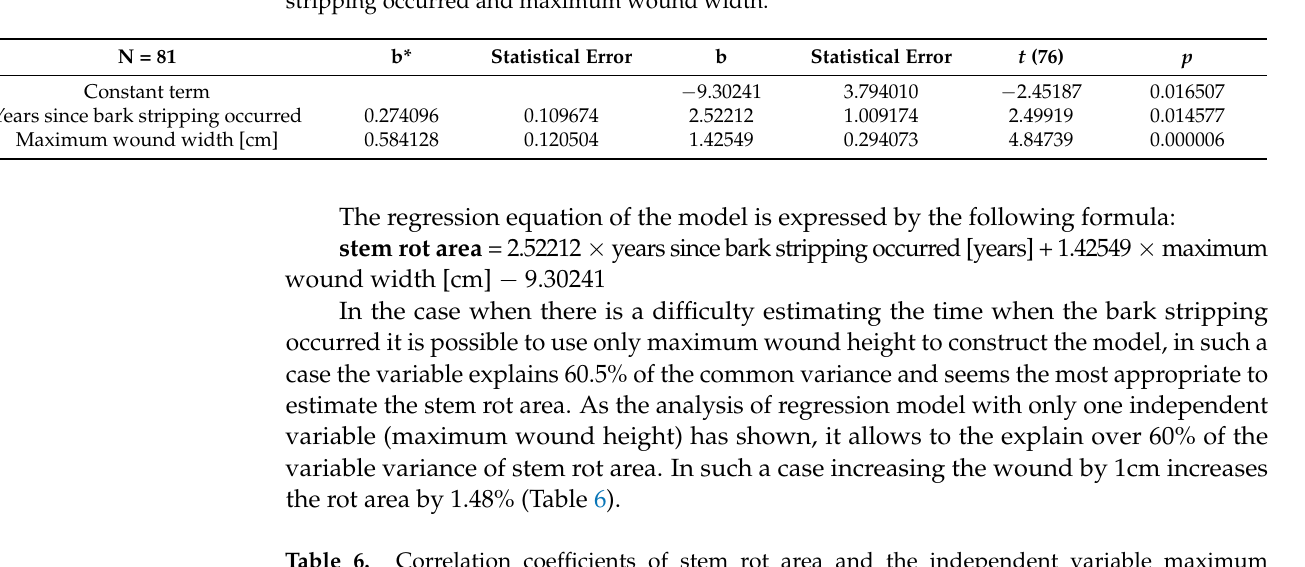
Table 5. Correlation coefficients of stem rot area and the independent variables of years since bark stripping occurred and maximum wound width.